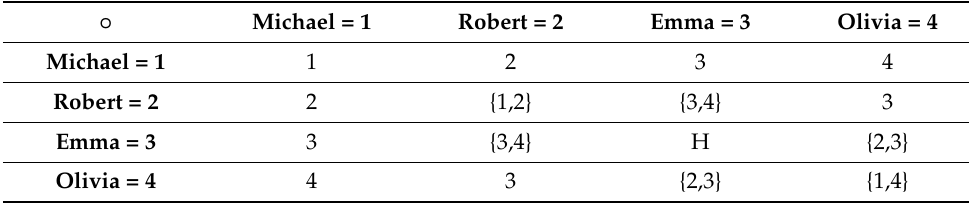
Table 2. Hypergroup ( H , ◦ )